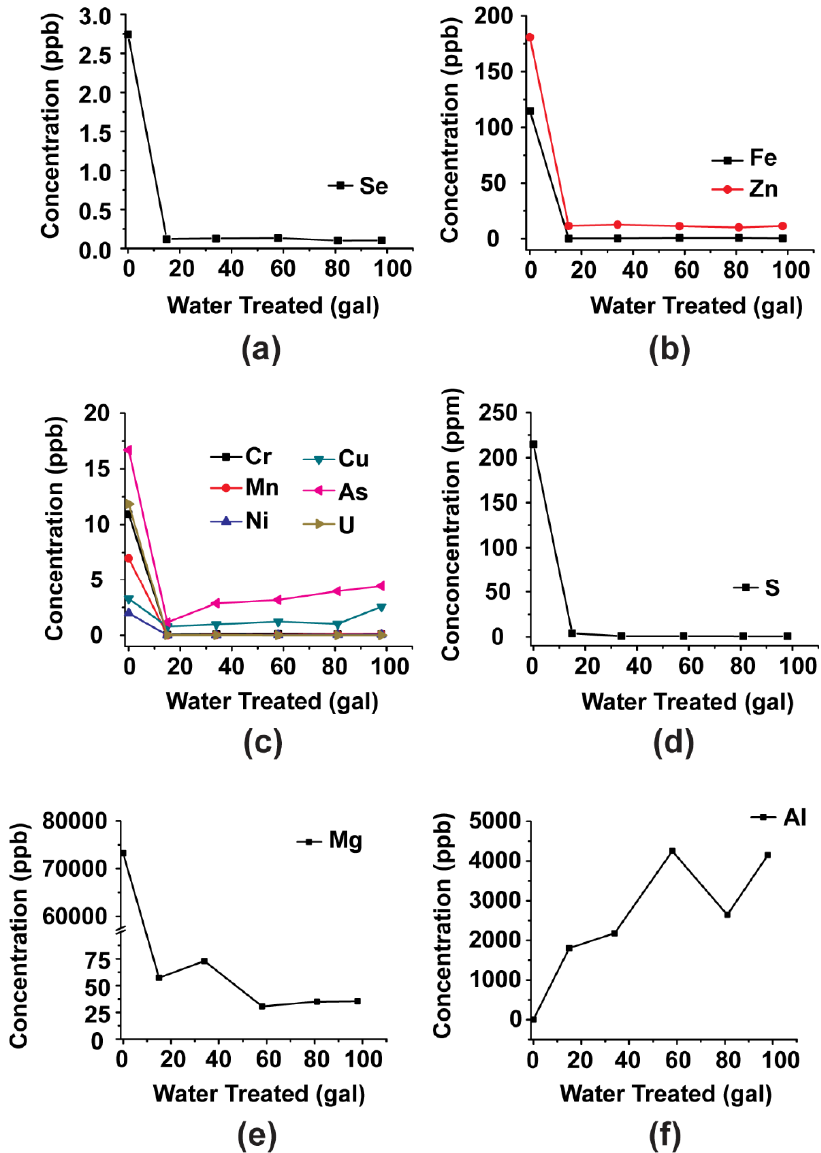
Figure 7. Concentration of select ions in CT blowdown water effluent from pilot test. Table 4. Comparison of select anion concentrations (in mg/L) in CT blowdown influent and